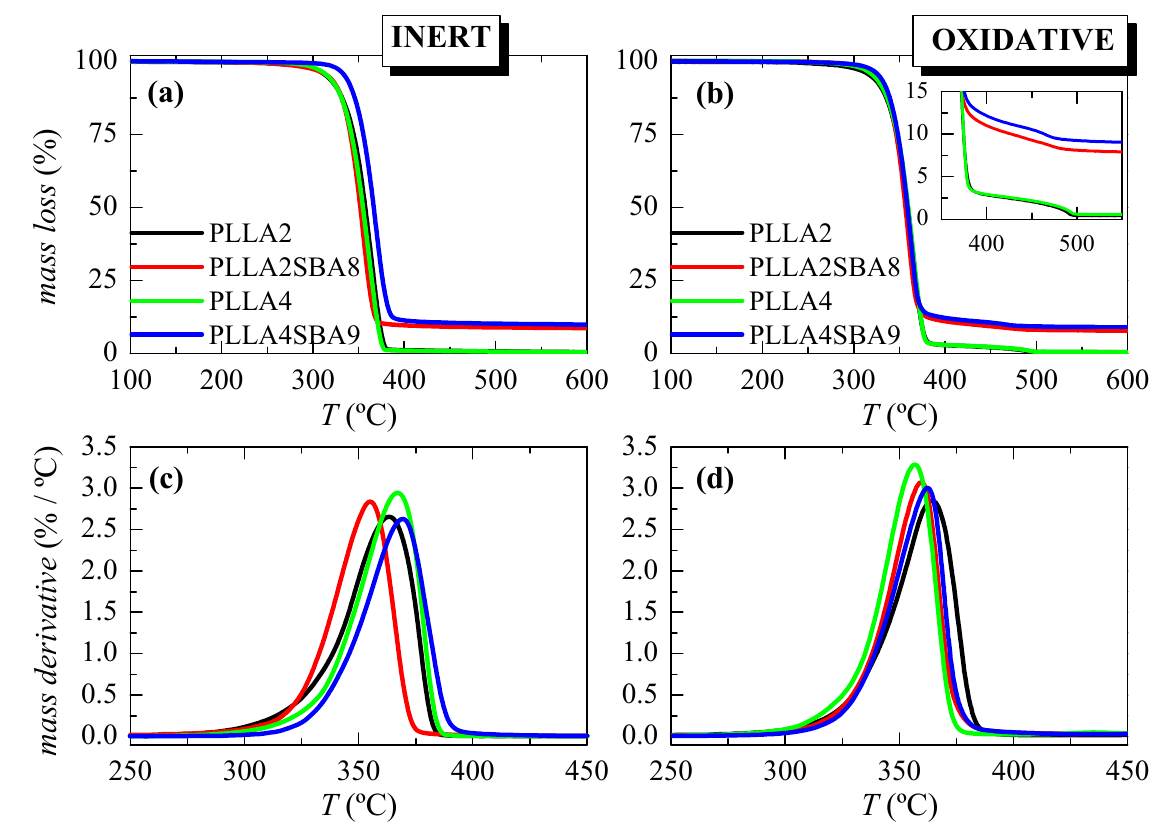
Figure 2. TGA curves under nitrogen (left) and air (right) atmospheres for the pristine PLLA matrices and their SBA-15 composites attained by extrusion (( a , b ) representations); and their DTGA curves (( c , d ) representations). Table 2. TGA results under inert and oxidative environments for neat PLLAs and their composites attained by melt extrusion: temperature of the 10% loss mass ( T 10% ) and maximum temperature ( T max ) together with the SBA-15 wt.% amount estimated from both atmospheres and its average. Average Sample SBA-15